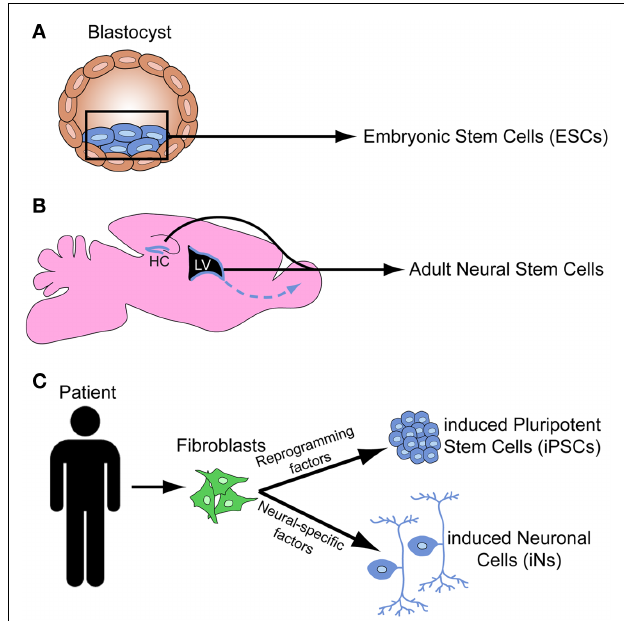
FIGURE 1 | Schematic depicts the origin of embryonic stem cells from the inner cell mass of the blastocyst (A), the stem cell niches in the subventricular zone and the hippocampus in the adult mouse brain (B), and the induced pluripotent stem cells and induced neural cells derived from human fibroblasts